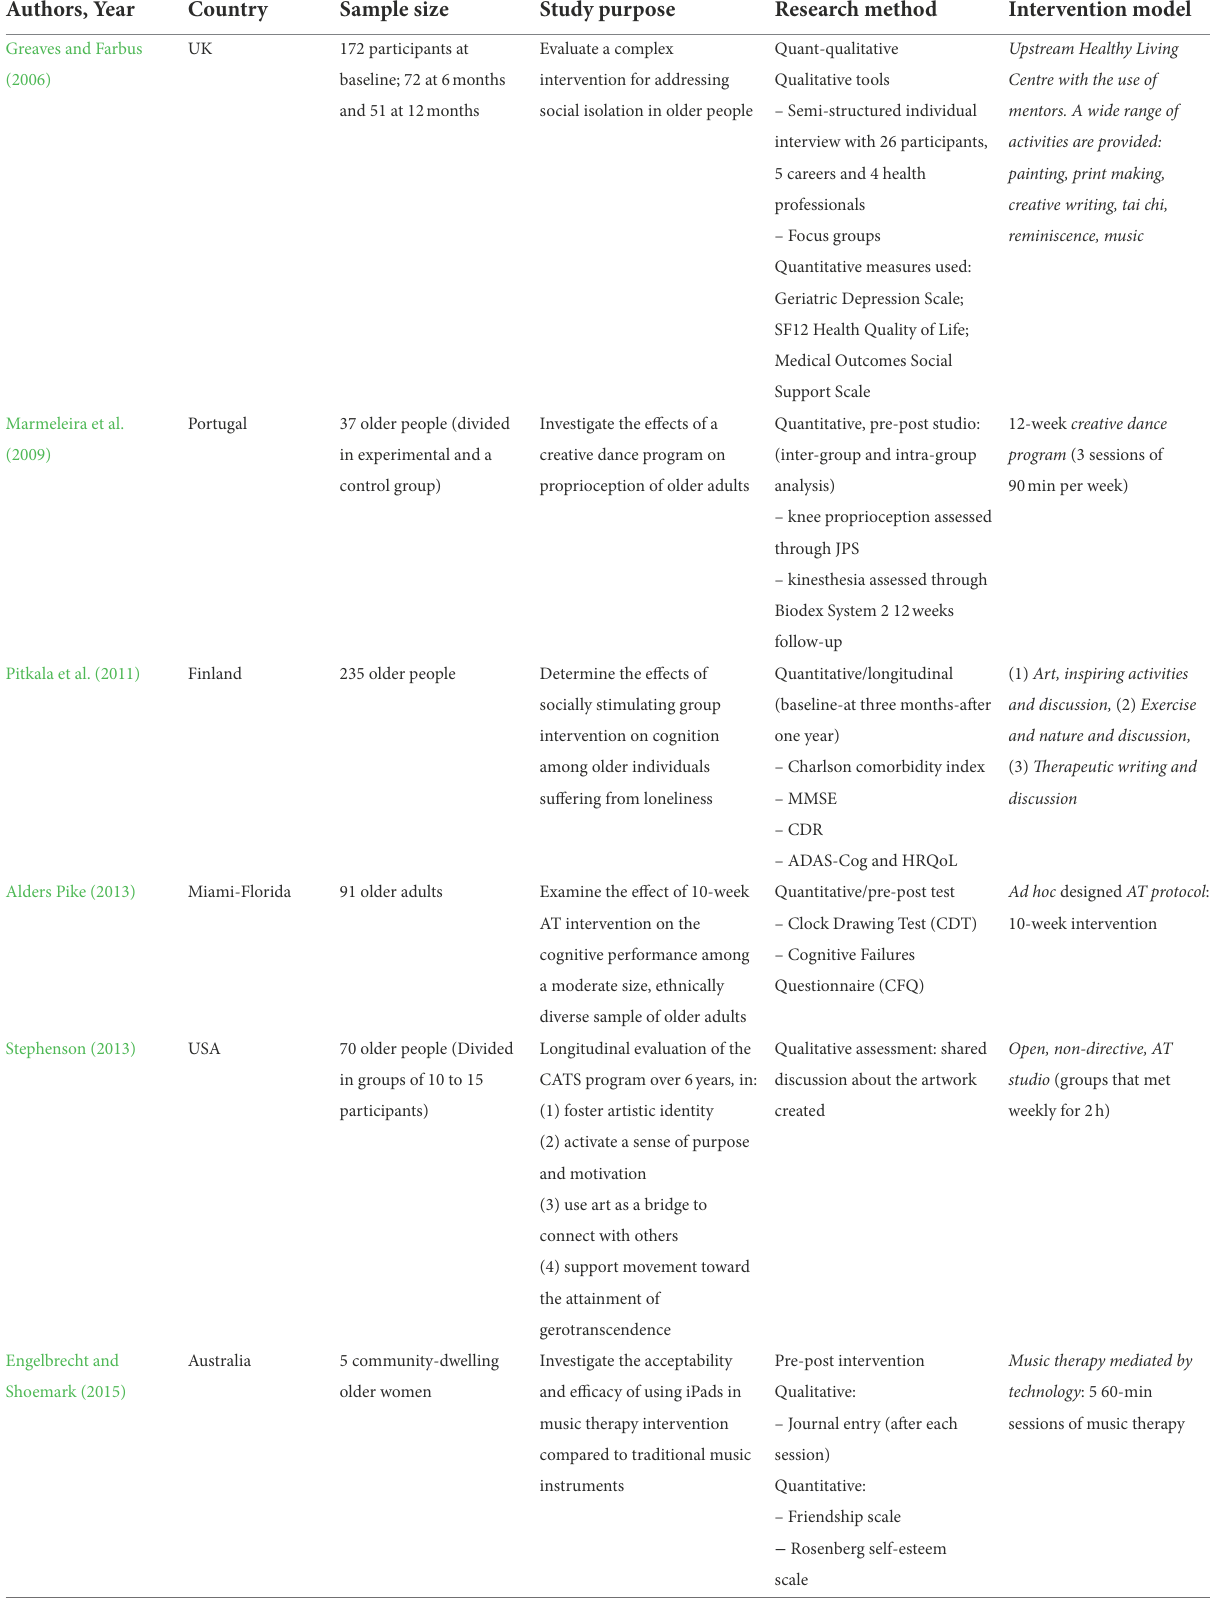
TABLE 2 Selected studies by purpose and